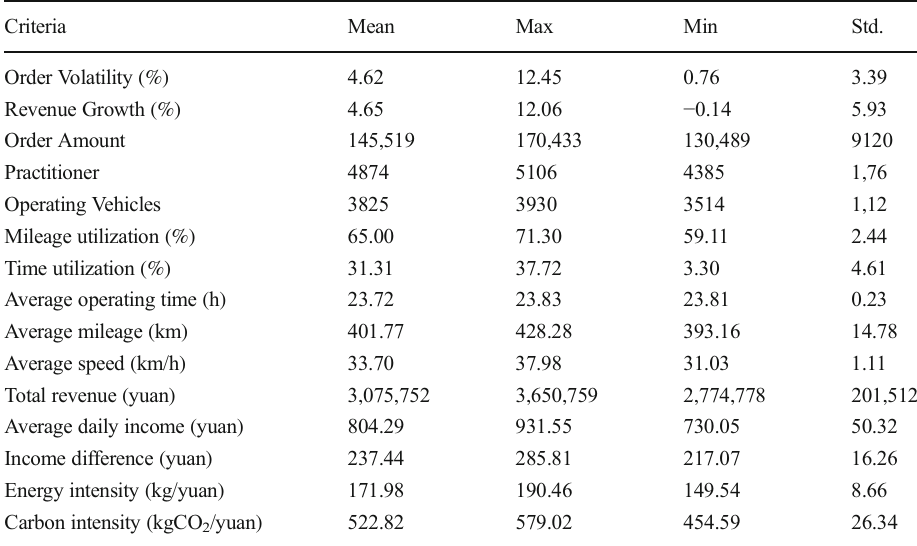
Table 5 Typical value of criteria in Wuxi taxi industry Criteria